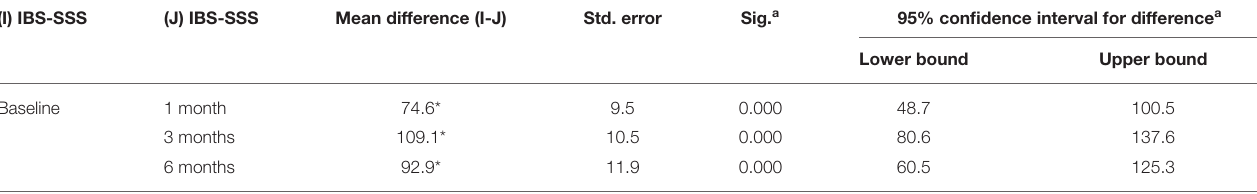
TABLE 2 | Pairwise comparison based on estimated marginal